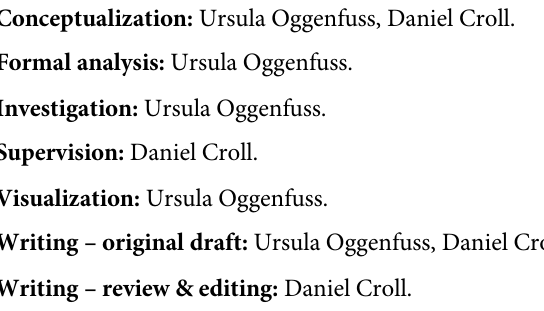
S2 Table. Description of all TE copies analyzed: assigned TE family, information about iso- late of origin, position in the genome, niche and TE sequence